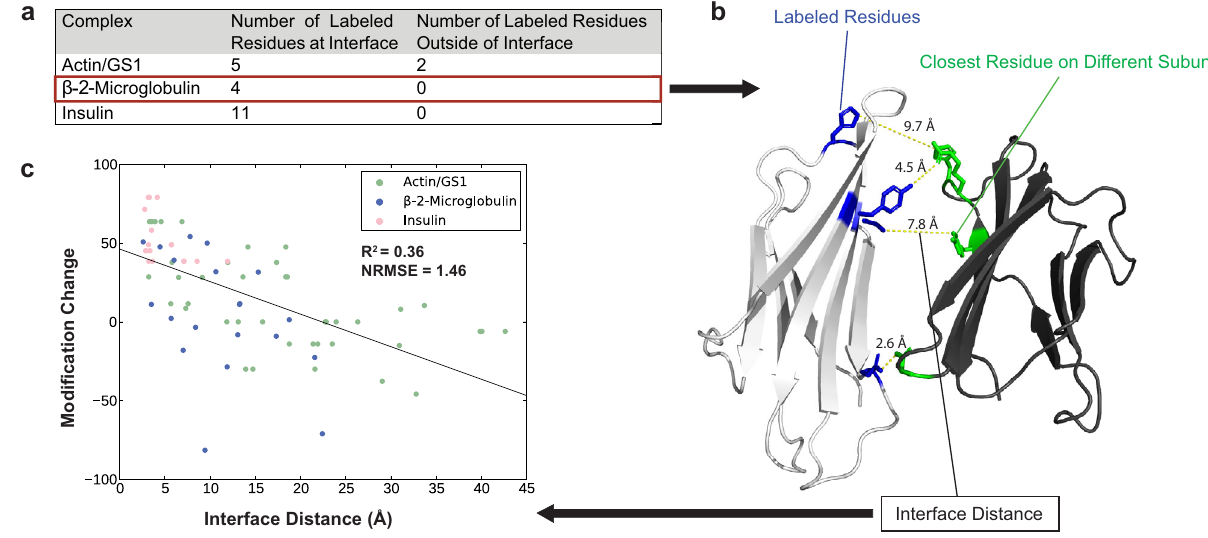
Fig. 1 | Quantifying the relationship between modi fi cation change and proxi- mity to interface. a Breakdown of the residues with a modi fi cation change of at least 40%, within and outside the binding interfaces of a speci fi ed complex. The residues shown in Panel (a) are a subset of the residues shown in Panel c . b Visualization of the four labeled residues with large modi fi cation changes (see Panel a )foronesubunitofthe β − 2-microglobulinhomodimercrystalstructure.The